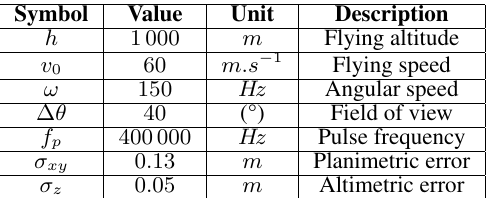
Figure 3. Result of the different algorithms evaluated on a crossroad of the scene Symbol